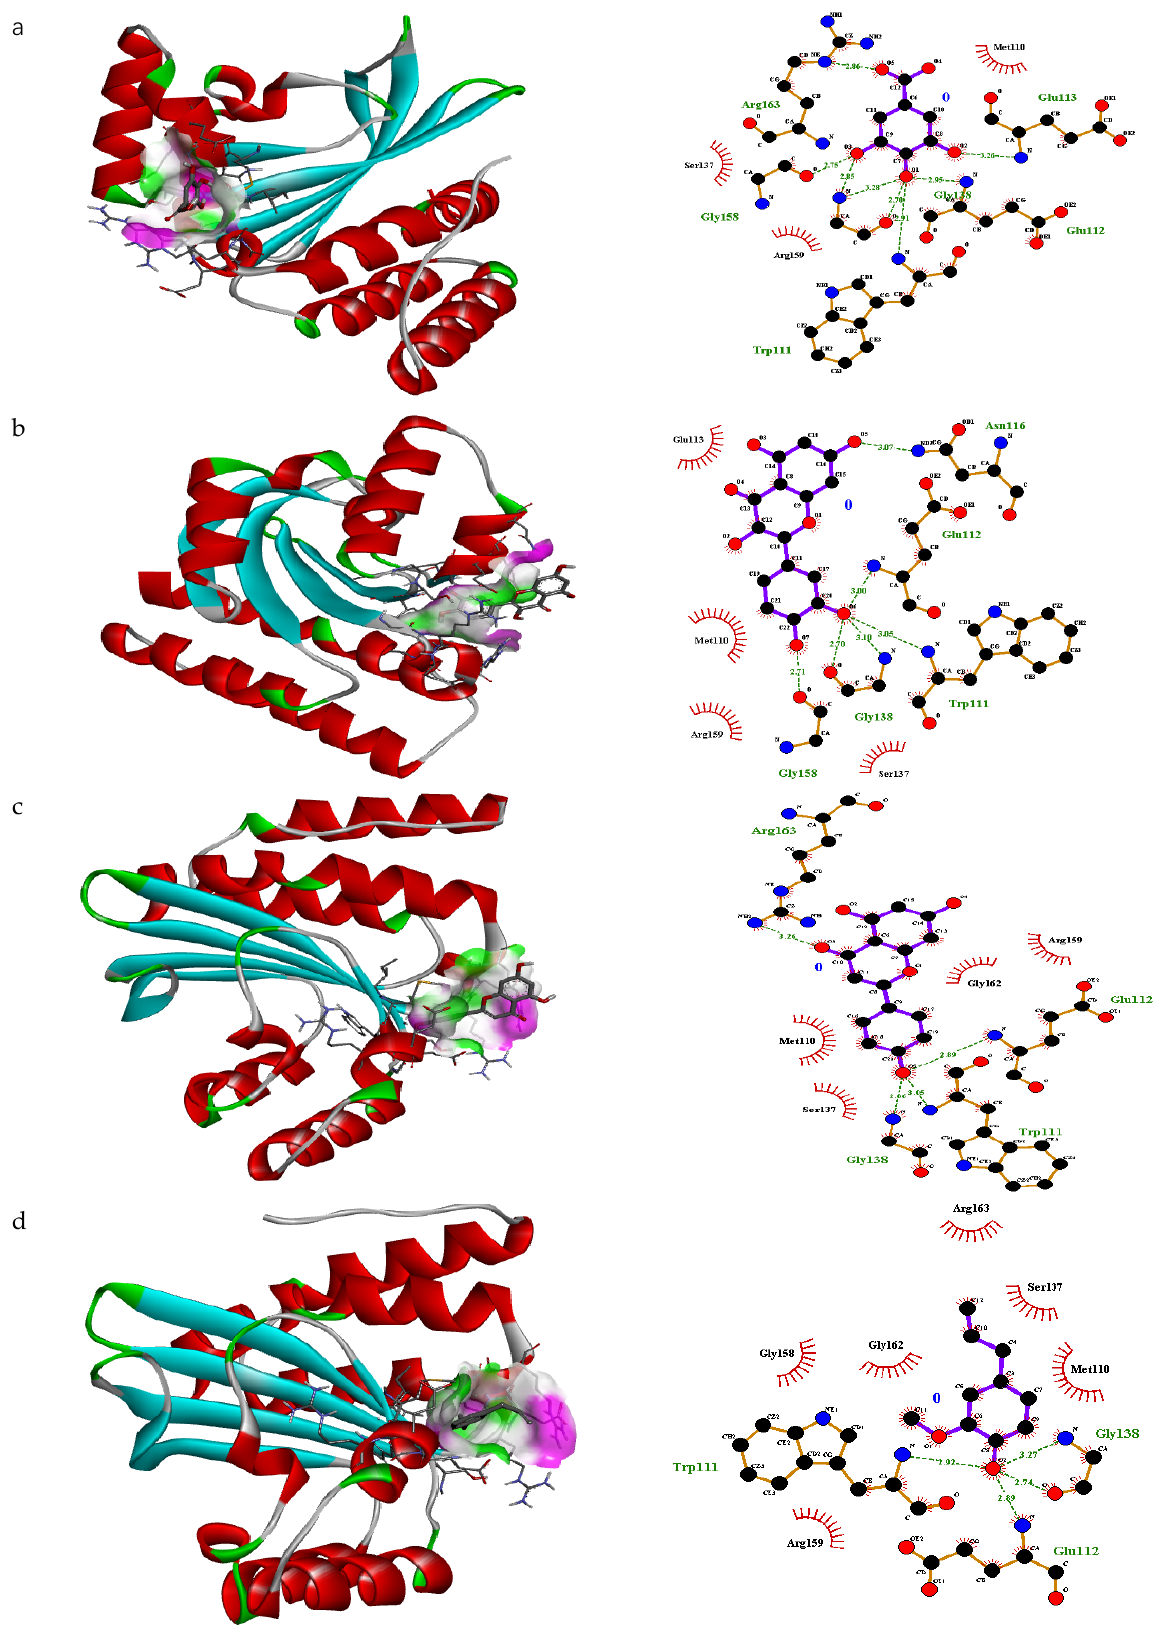
Figure 2. 3D interaction and H, non-H bonding interactions of ( a ) gallic acid (pose 1), ( b ) quercitrin (pose 4), ( c ) apigenin (pose 3) and ( d ) eugenol (pose 6) inside binding sites of transcriptional regulator 3QP1 with pose rank